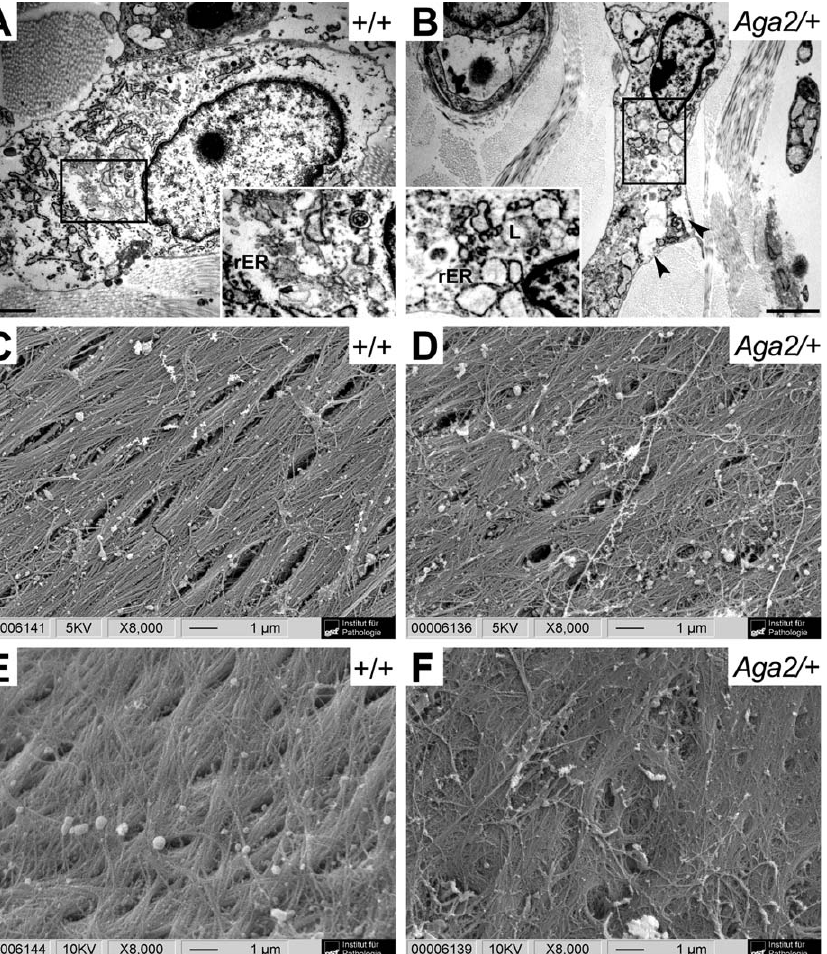
Figure 3. Electron Microscopical Findings in Dermal Fibroblasts and Cortical Bone (A,B) TEM micrographs of wild-type and Aga2 / þ fibroblasts. The rough endoplasmatic reticulum (rER) is engorged in Aga2 / þ cells (bars, 2 l m for main, 1 l m for inset). Increased intracellular empty vacuoles (arrow heads) and lysomes (L) were present in Aga2 / þ . (C–F) SEMs of femoral endosteal surfaces reveal differences in organization of the collagen matrix (C,D) Outer cortical surface. (E,F) Inner cortical